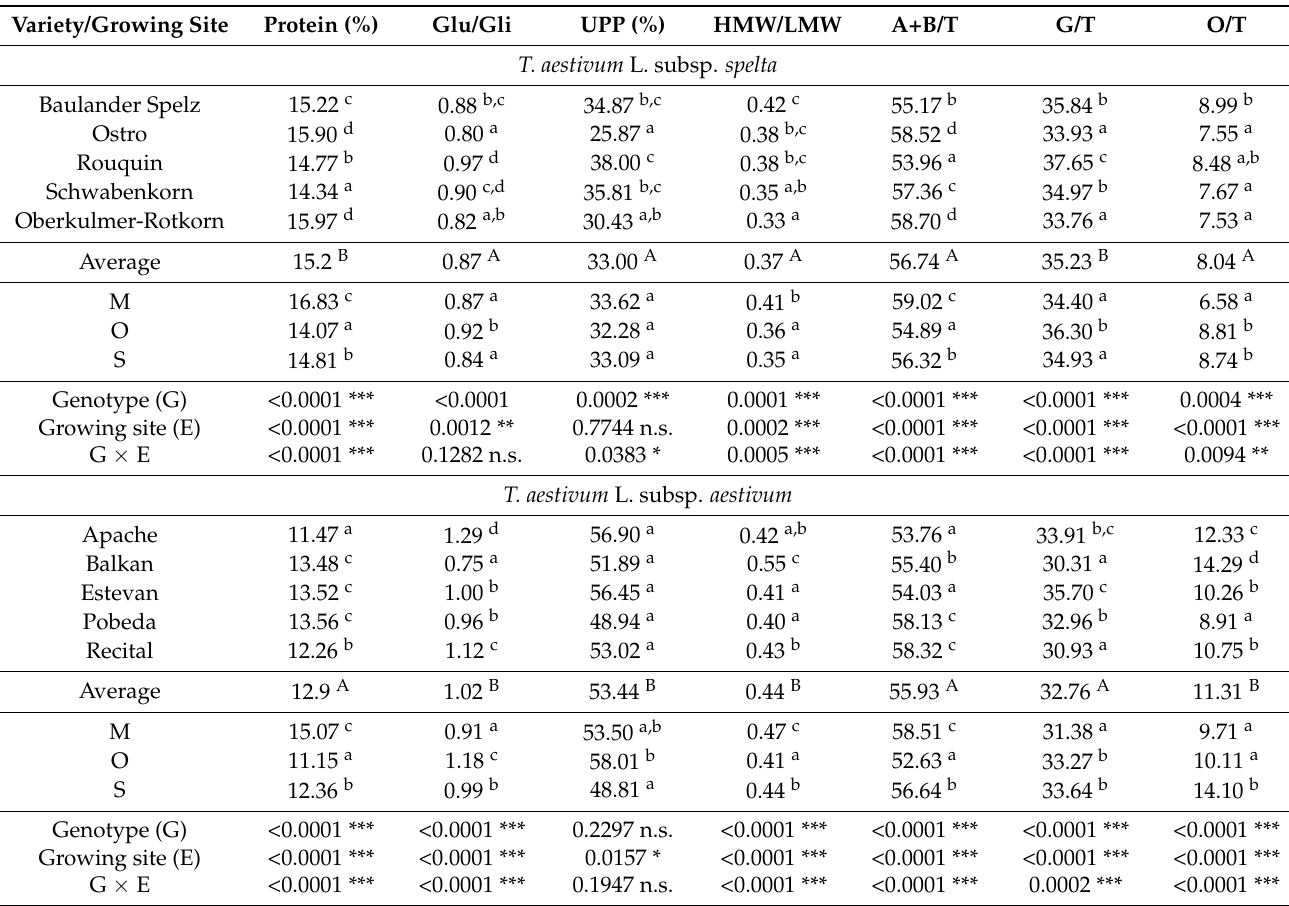
Protein—total protein content (%), Glu/Gli—the quantitative ratio of glutenins to gliadins, UPP—unextractable polymeric proteins (%), HMW/LMW—the quantitative ratio of high molecular weight and low molecular weight glutenin subunits, A+B/T—the portion of alfa and beta gliadins in total gliadins, G/T—the portion of gamma gliadins in total gliadins, O/T—the portion of omega gliadins in total gliadins; M—conventional growing site in Martonv á s á r, Hungary, O—organic growing site from Hungary, S—conventional